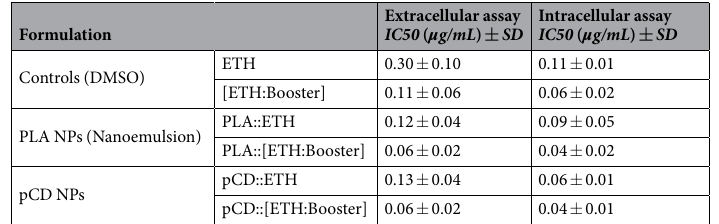
Table 2. Efficiency of the different formulations against M . tuberculosis H37Rv-GFP extracellular or intramacrophage replication. Results, expressed as concentration of ETH required to inhibit 50% of the bacterial growth in µ g/mL (IC 50 ), were calculated by nonlinear regression analysis using the equation for a sigmoidal dose-response curve with variable slope using the GraphPad Prism 5.0 software. Results are shown as the mean ± standard deviation of three independent experiments.